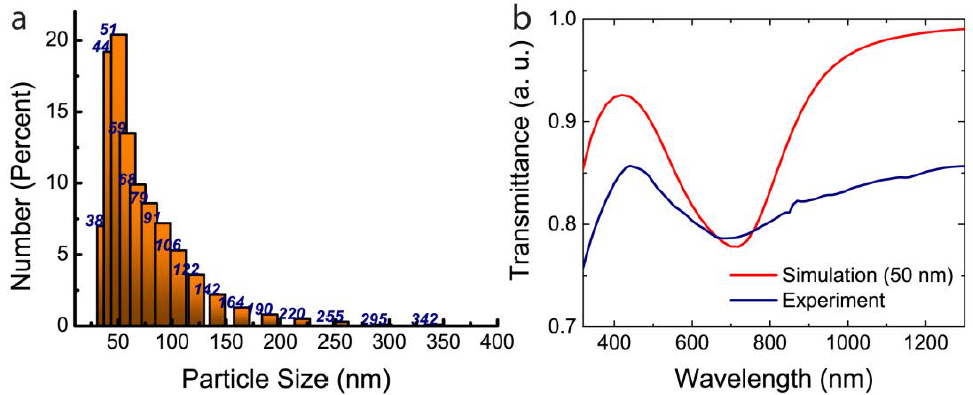
Figure 4: Dynamic light scattering measurement of the size dispersion for colloidal plasmonic TiN nanoparticles. Peak value around 50 nm is a desired size for more eflcient cellular uptake. The long tail with marginal large dimensions is likely due to clustering effects. (b) Trans- mittance data taken from aqueous TiN sample (blue) and calculated data for mono-sized 50 nm nanoparticle solution (red). Calculated transmittance with mono-sized nanoparticle solution agrees well on the peak spectral position and amplitude with the experimental data. Broader experimental peak can be attributed to the size dispersion as observed in dynamic light scattering